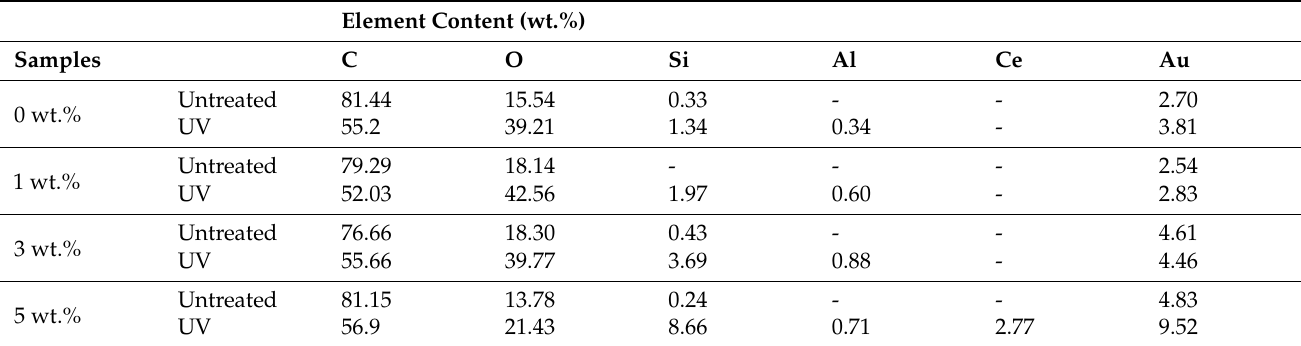
Table 2. EDX results of samples before and after the UV exposure. Element Content (wt.%) Element Content